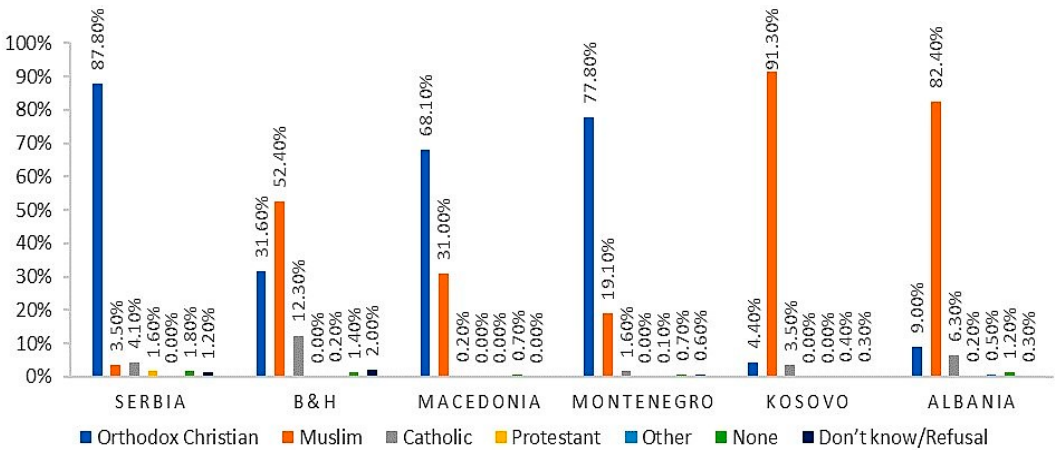
Figure 1. Confessions among countries based on confessional self-declaration.